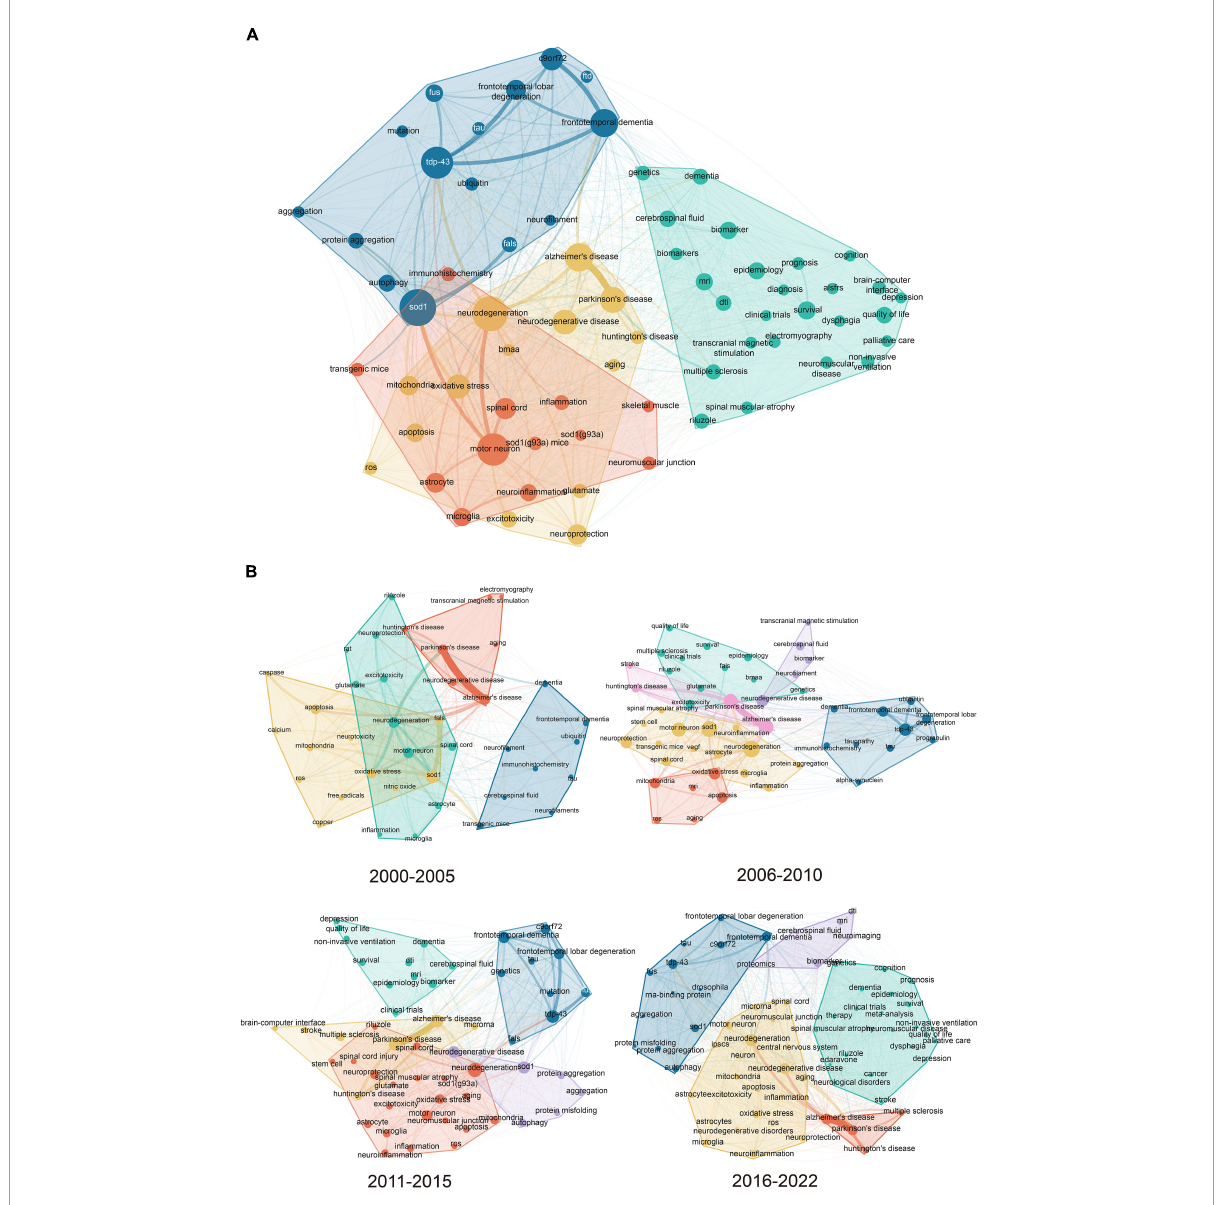
FIGURE3 (A) Keyword co- occurrence network with clustering. (B) Subgroup analysis by time period in the keyword co-occurrence network (the circle size represents the frequency of occurrence; the color represents the cluster wherein the keyword belongs to; and the line thickness between two circles represents how two keywords co-occurred with each other in the